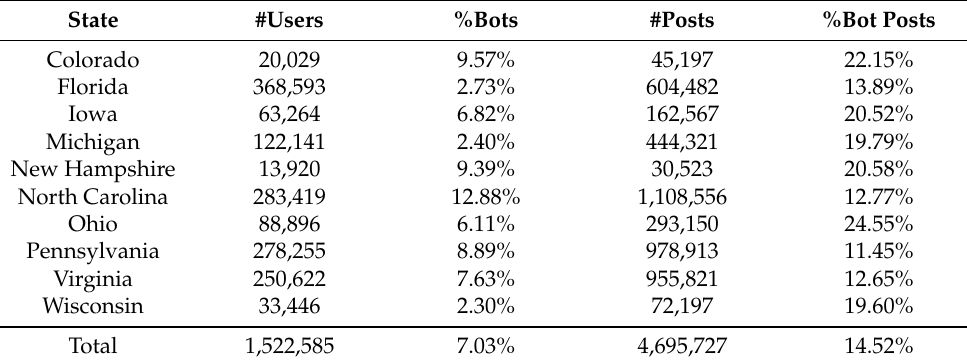
Table 1. Collected posts and users per state.